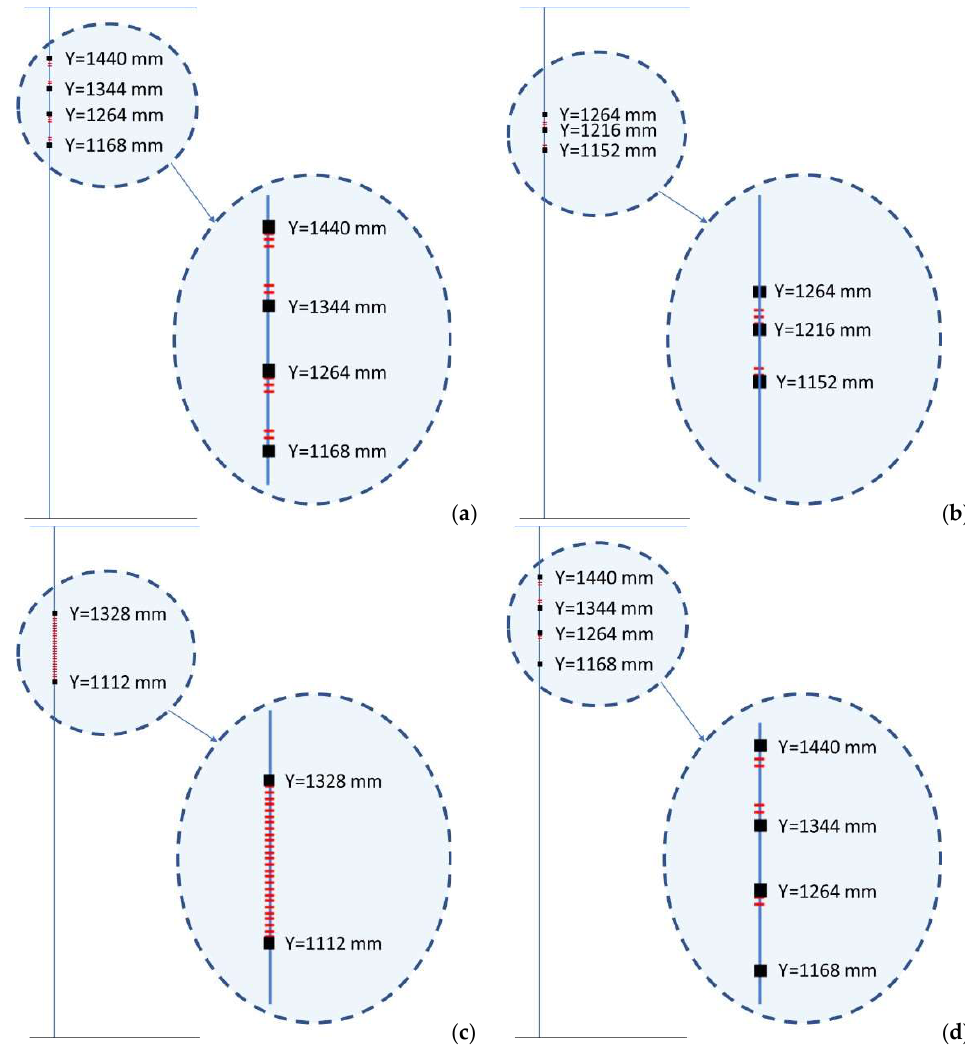
Figure 40. Graphical representation of test case results referred to the quadruple of loads type ap- plied ( left ), and a magnification of the area of interest ( right ). The figure is not to scale.